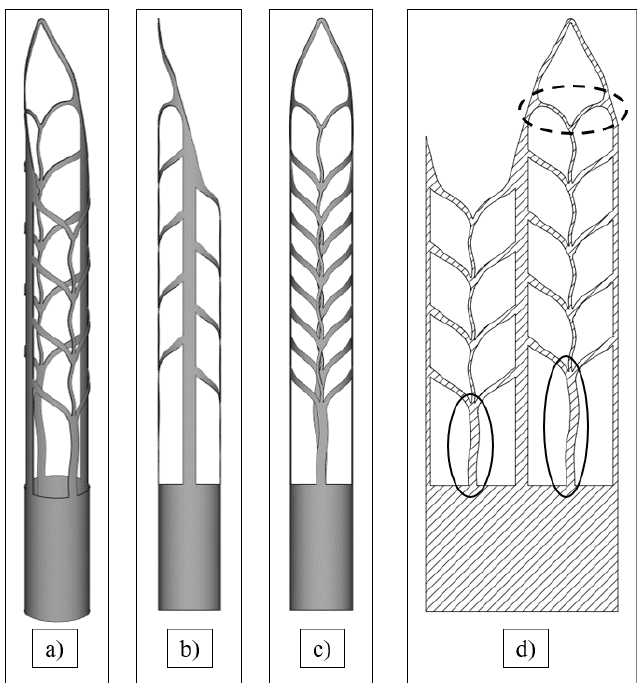
Figure 2. 3D-model of Self-Adjusting File adopted for LPBF manufacturing: ( a ) isometry; ( b ) XZ plane view; ( c ) YZ plane view; ( d ) sweep of the SAF, supplemental support strut highlighted with a solid line, critical inclined angle highlighted with a dashed line.